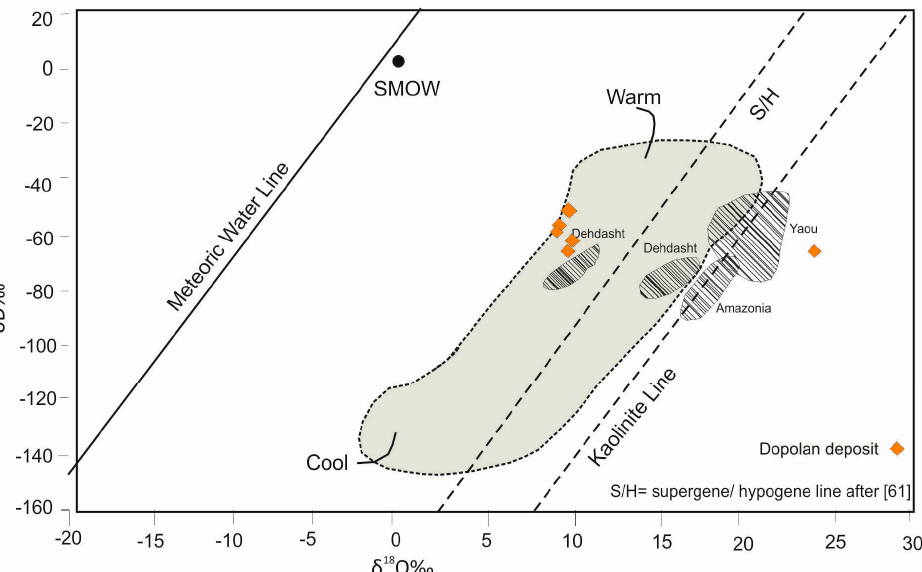
Figure 16. δ 18 O and δ D values of the Dopolan kaolinite compared with data from Amazonia (after [60]), Yaou (after [58]) and Dehdasht after [27]. Kaolinite line (after [59]). SMOW = Standard Mean Ocean Water; S/H = supergene/hypogene line after [61].